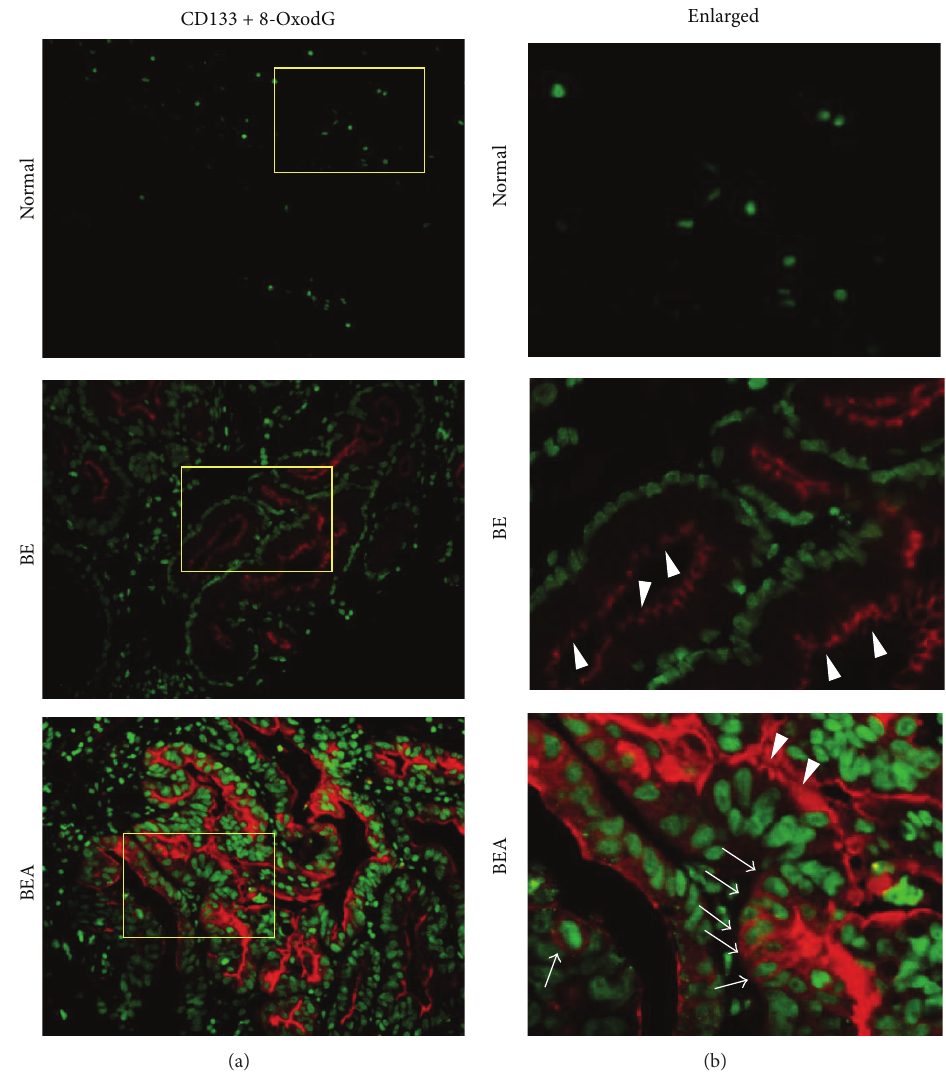
Figure 3: Double immunofluorescence staining of CD133 and 8-oxodG in normal esophageal (Normal), Barrett’s esophageal (BE), and Barrett’s esophageal adenocarcinoma (BEA) tissues. CD133 and 8-oxodG were stained in red and green, respectively. The original magnification is × 200 (a). (b) represent enlarged pictures of the yellow boxes in the (a). Arrowheads indicate CD133 expression in apical surface. Arrows indicate cell membrane and cytoplasmic CD133